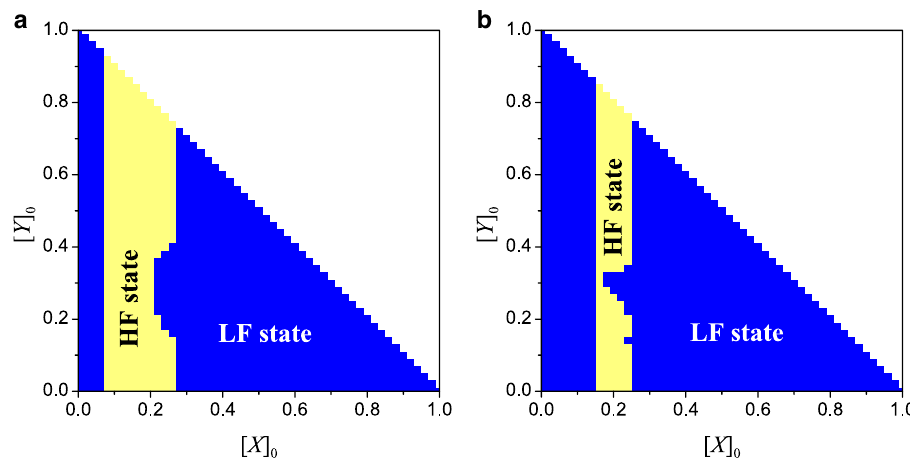
Fig. 6 Basin structure of NMR model. On the [ X ] 0 − [ Y ] 0 plane, basin structure from a mean- fi eld theory and b simulations. The colors indicate the nature of the steady states given the initial conditions ([ X ] 0 , [ Y ] 0 ). The parameter setting is the same as that in Fig. 3 for the MR model. The simulation results are obtained by averaging over ten